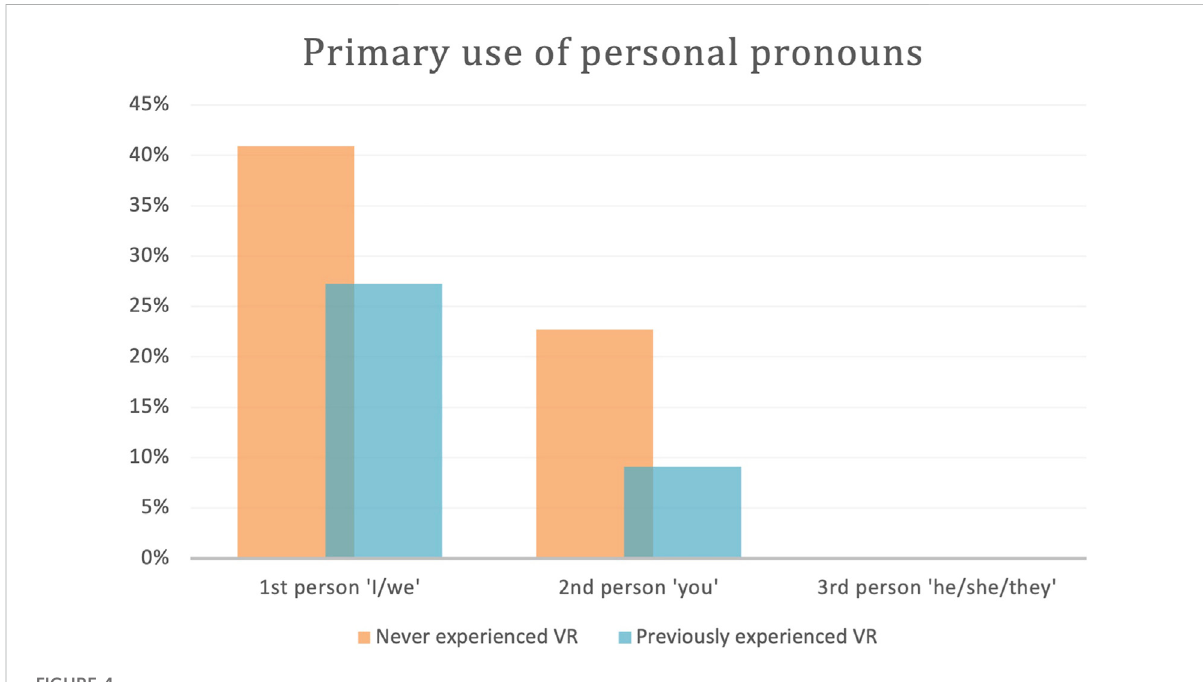
FIGURE 4 Chart illustrating study participant ’ s primary use of personal pronouns.